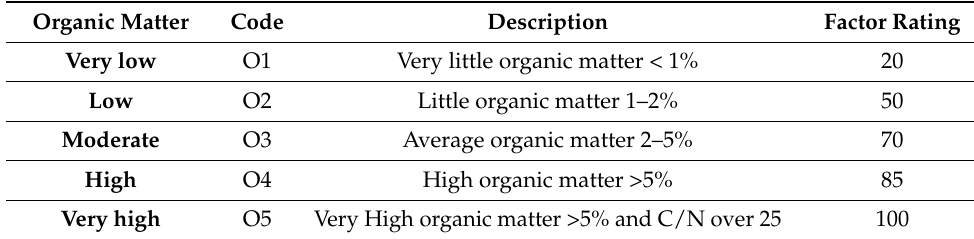
Table 8. Factor ratings of organic matter (%).